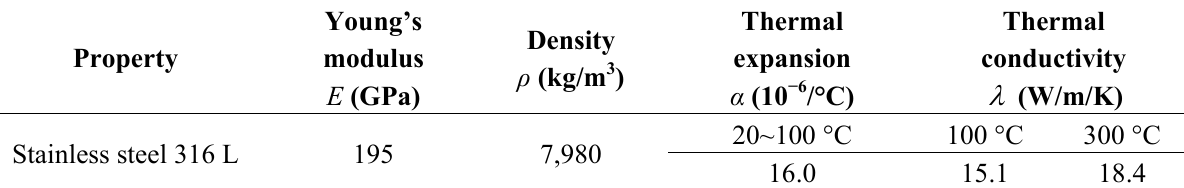
Table 1. Material properties for stainless steel 316 L.